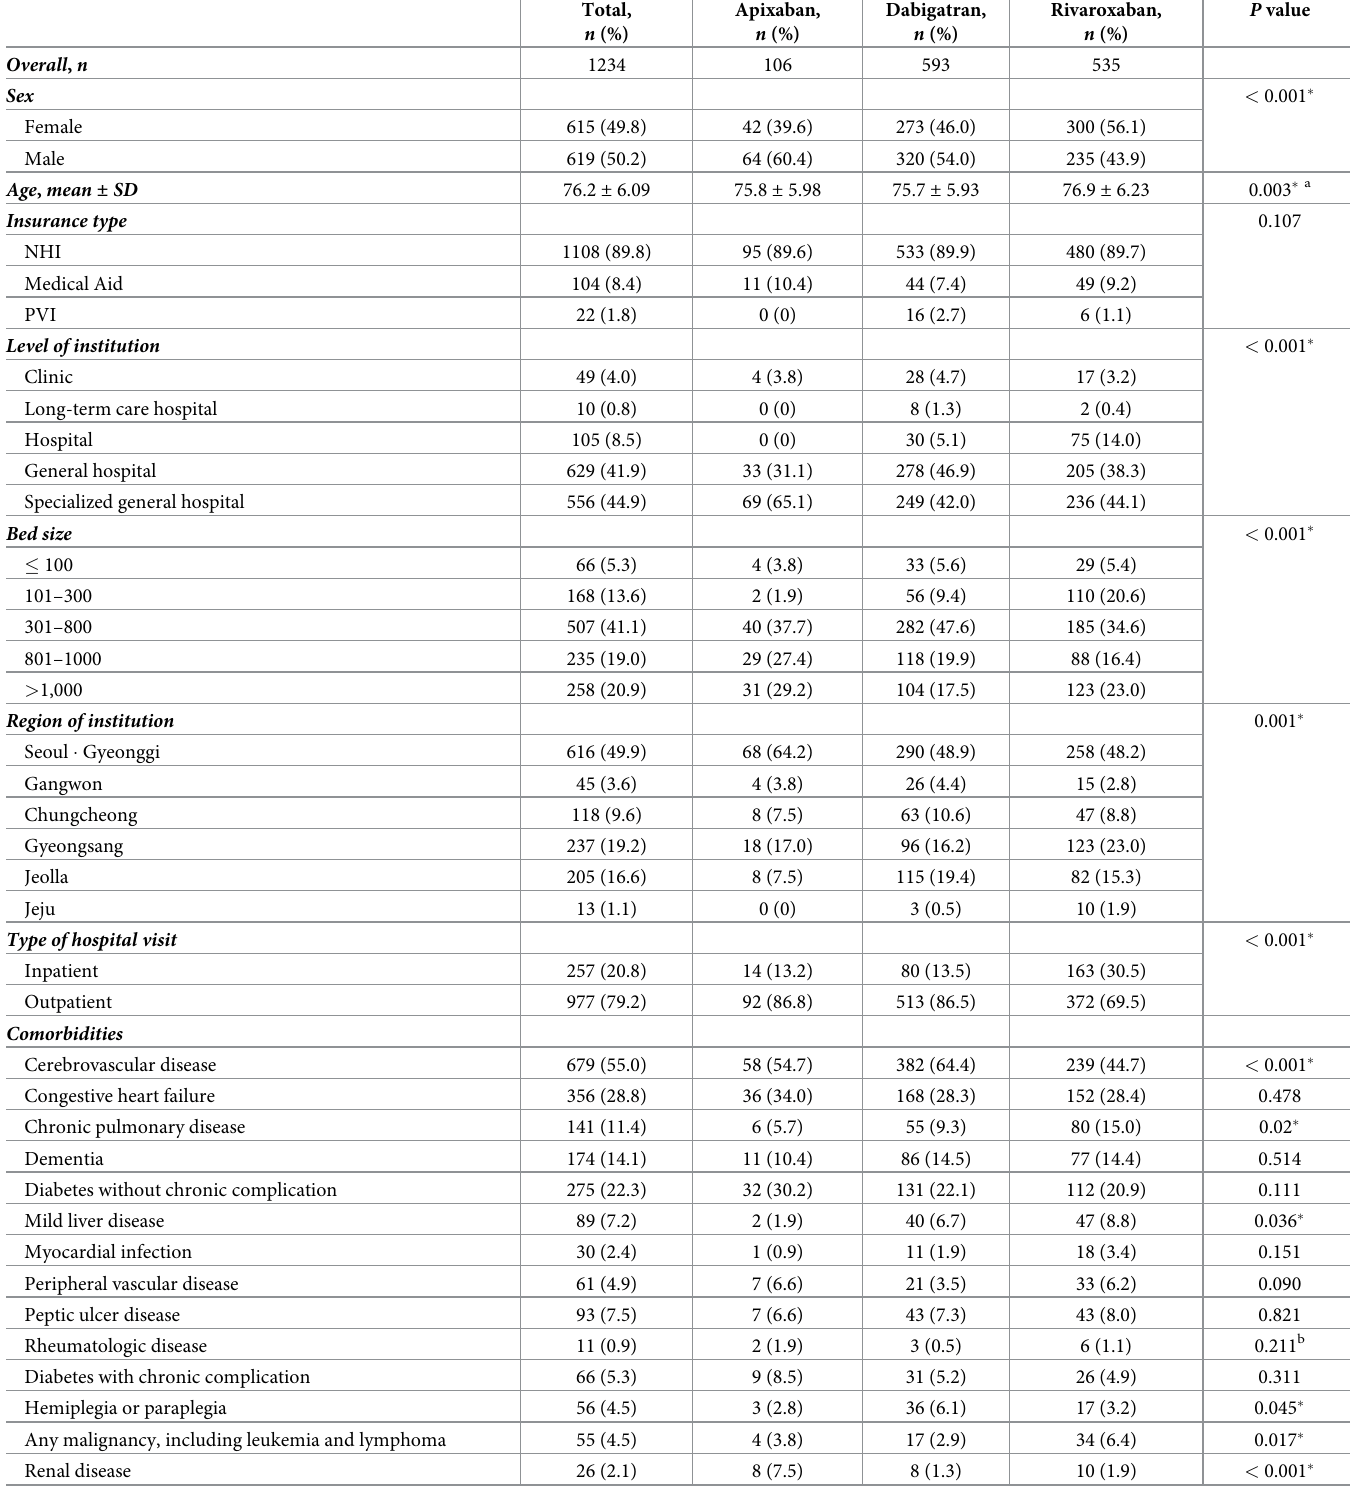
Table 1. Demographic characteristics of the study